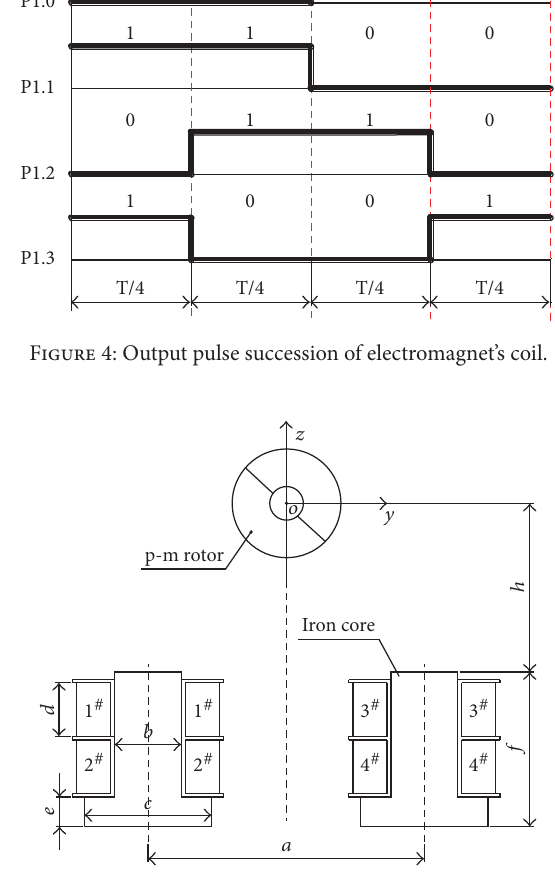
Figure 5: The electromagnet iron core structure of magnetic drive